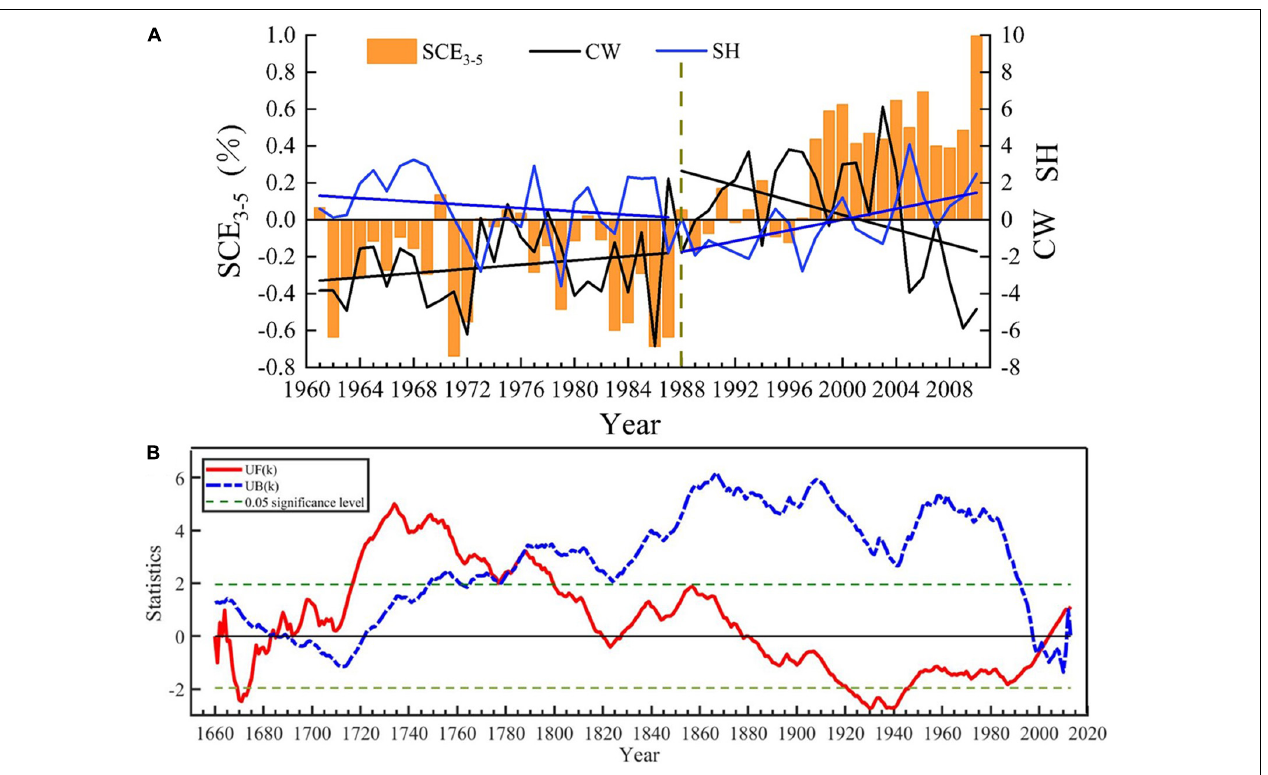
FIGURE 6 | (A) Interannual variation of the anomalies of the East Asian trough location index (CW), Siberian High index (SH), and the reconstructed SCE 3 − 5 values for 1961–2010 on the SETP, and (B) the M-K abrupt test of reconstructed SCE 3 − 5 values during the period of 1660–2013. The green horizontal dotted lines indicate the 0.05 significance